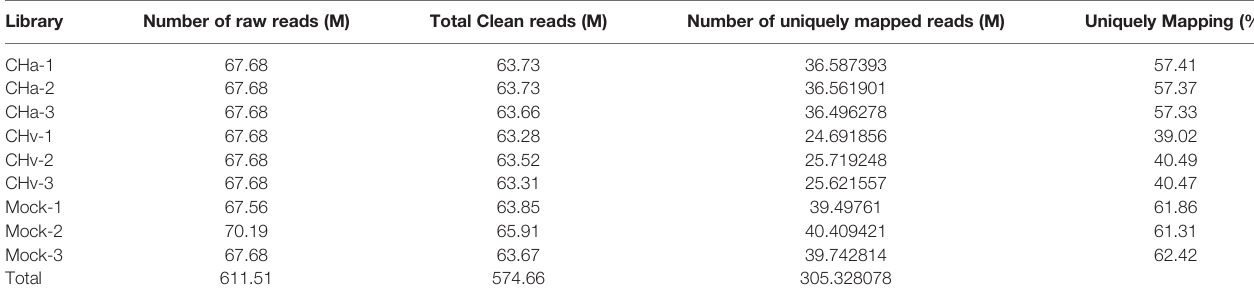
TABLE 2 | The number of reads of all bases detected using RNA-seq in DPV-infected and control cells.